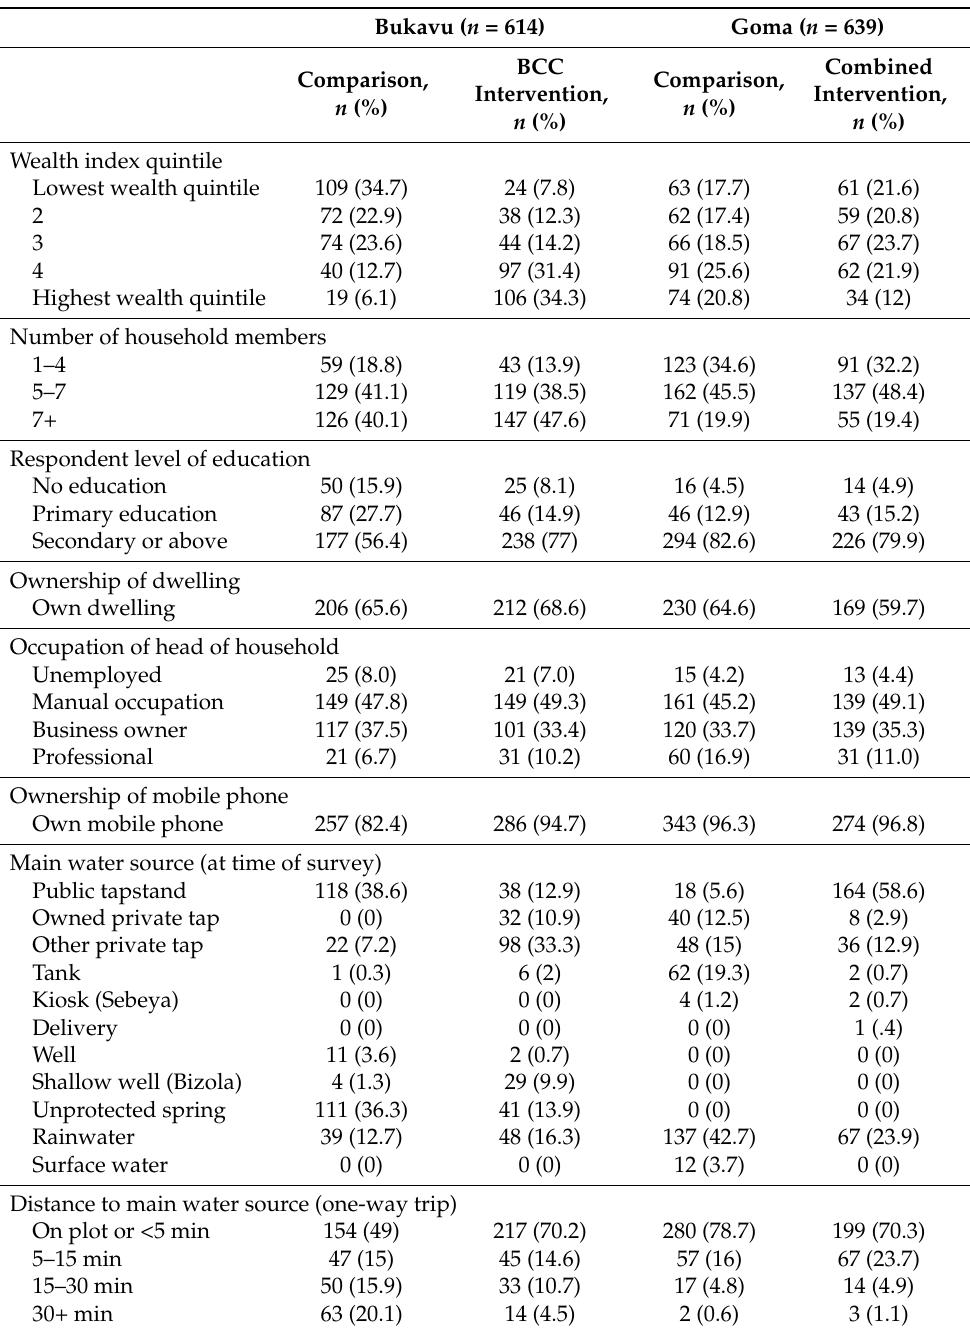
Table 2. Socio demographic and water access characteristics of households in Goma and Bukavu by study